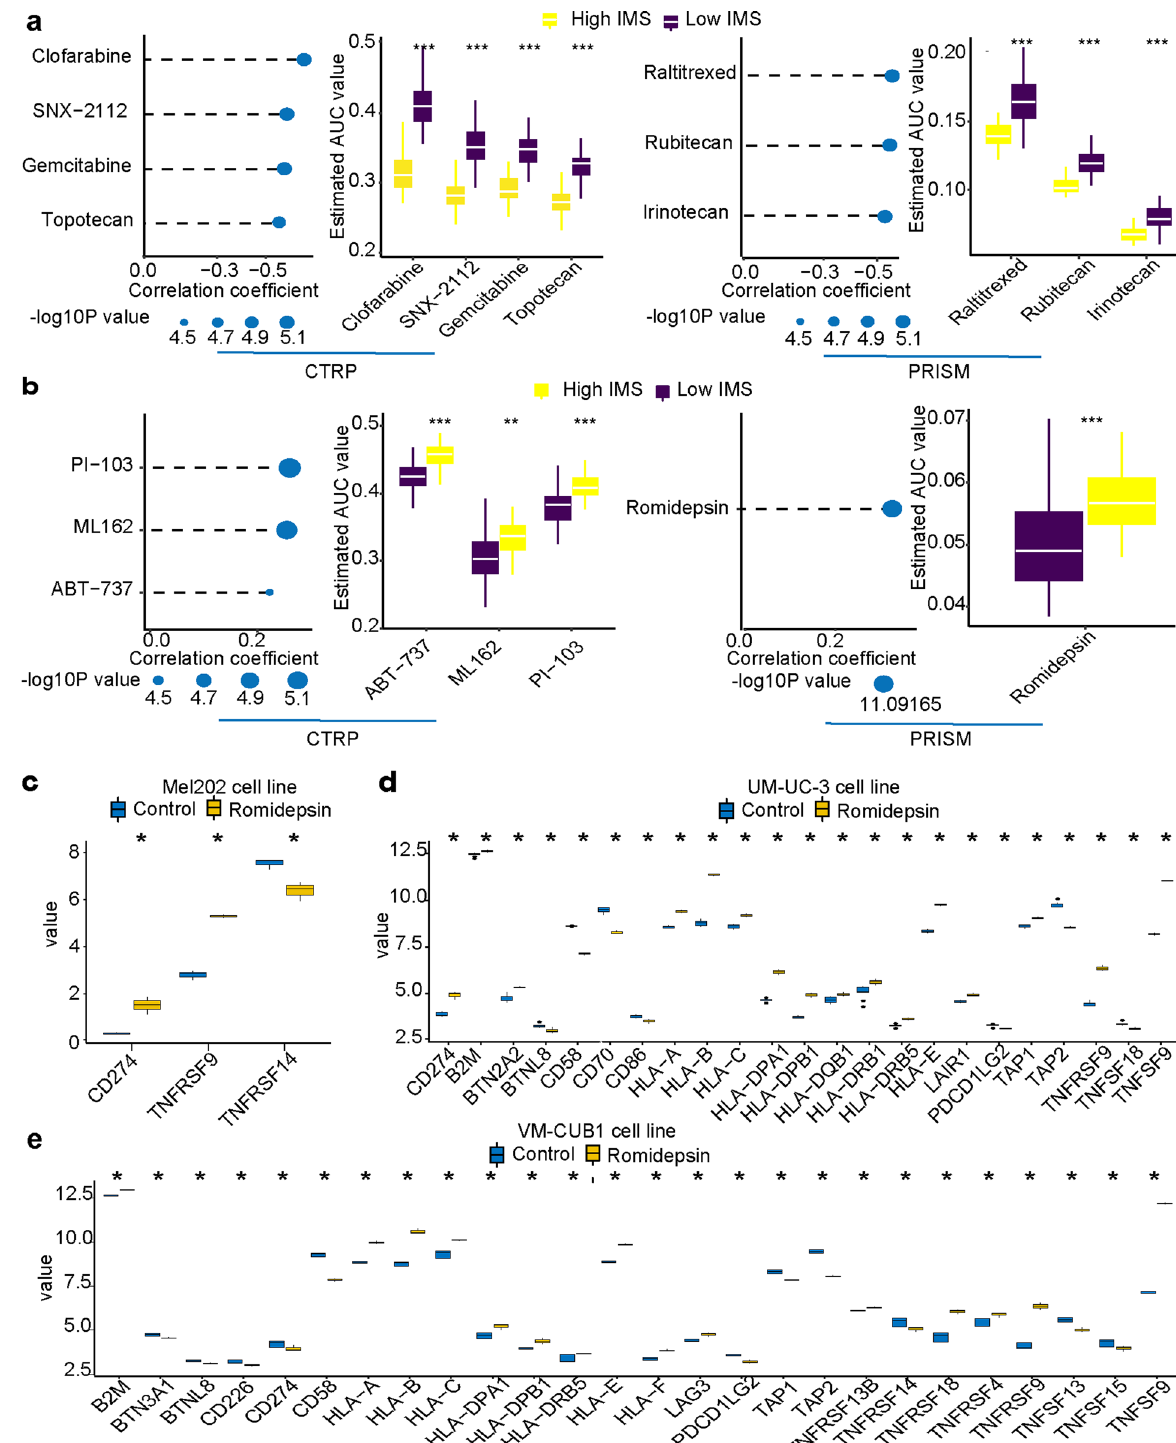
Fig. 7 Prediction of the sensitivity to chemotherapy drugs in patients with a high and low IMS. a Drugs sensitive to chemotherapy in patients with a high IMS. b Drugs sensitive to chemotherapy in patients with a low IMS. * P < 0.05, ** P < 0.01, *** P < 0.001, **** P < 0.0001. c Differentially expressed costimulatory and coinhibitory molecules after romidepsin treatment in the mel202 cell line. d Differentially expressed MHC, costimulatory, and coinhibitory molecules after romidepsin treatment in the UM-UC-3 cell line. e Differentially expressed MHC, costimulatory, and coinhibitory molecules after romidepsin treatment in the VM-CUB1 cell line. * P < 0.05. The center line of all boxplots represents the median value. The bottom and top of the boxes are the 25th and 75th percentiles (interquartile range). The whiskers encompass 1.5 times the interquartile